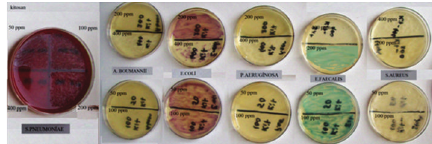
Figure 9: Antibacterial activity of chitosan-Ag nanoparticle mate- rials synthesized with 0.04 M AgNO 3 .